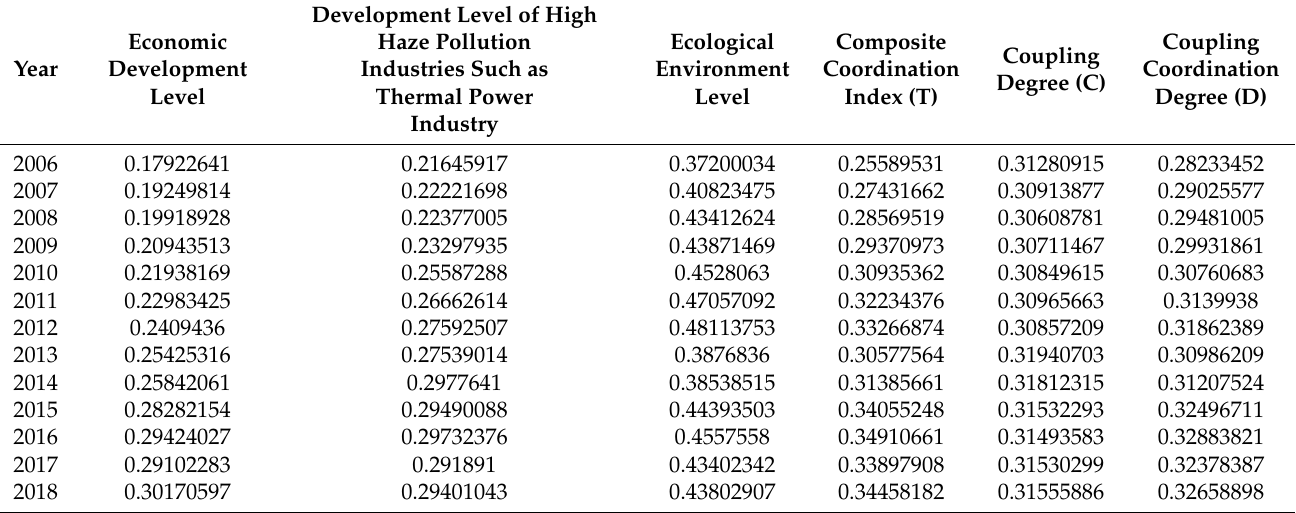
Table 3. Coupling degree and coupling coordination degree of local economy–ecological environment– high haze pollution industries, such as the thermal power industry in the Beijing–Tianjin–Hebei